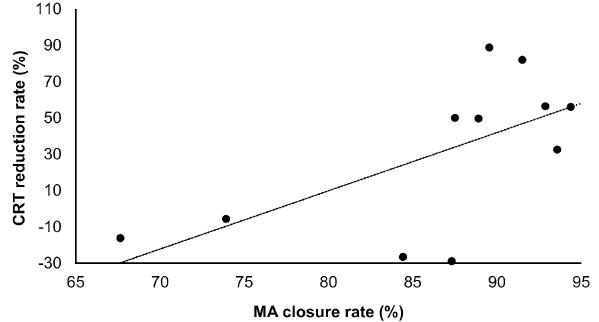
Figure 2. Correlation between microaneurysm closure rate and the central retinal thickness reduction rate. CRT, central retinal thickness.